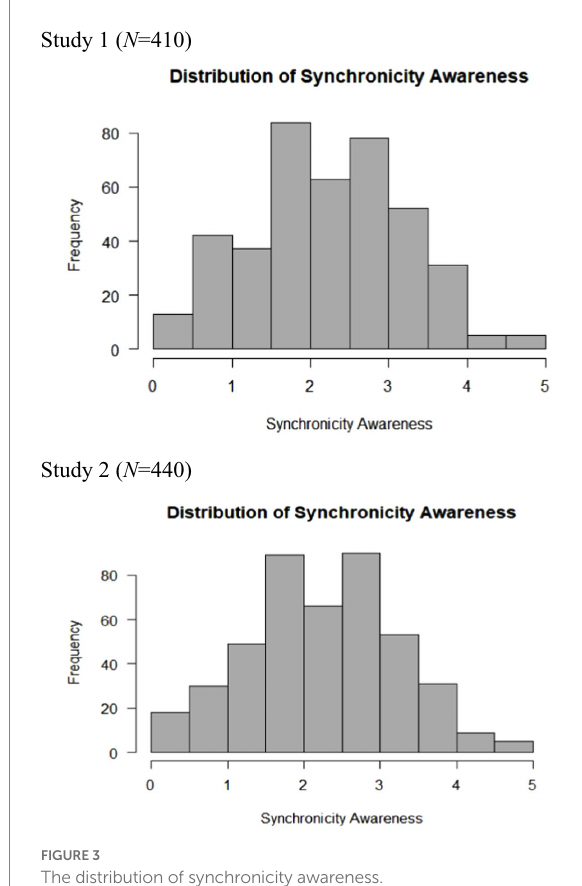
FIGURE 3 The distribution of synchronicity